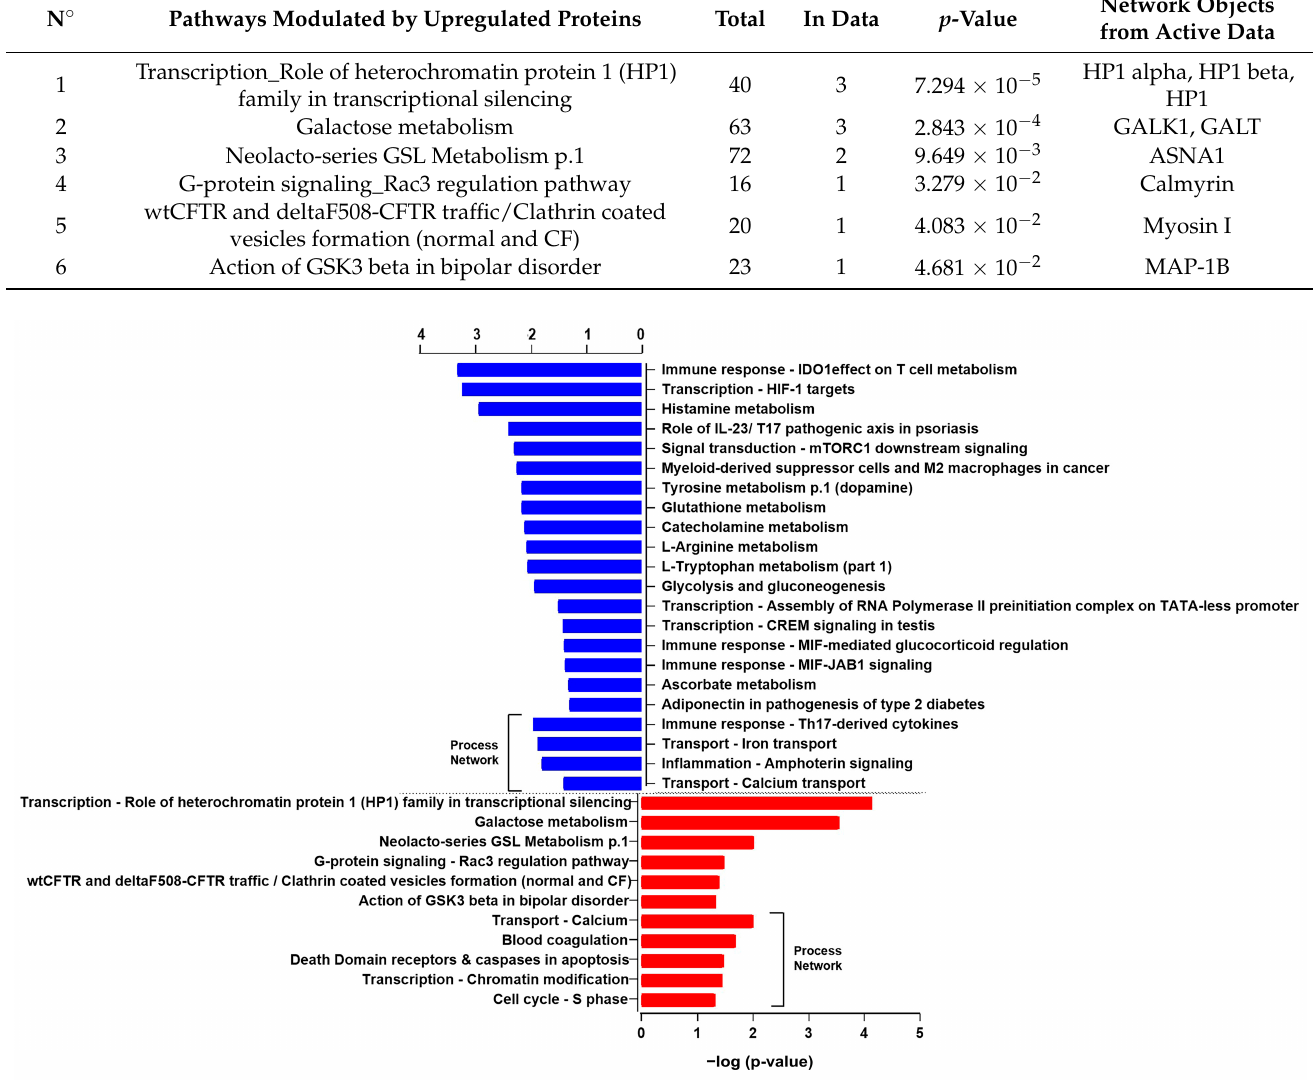
Figure 2. MetaCore enrichment analysis of proteomics data in LNCaP PCa cells overexpressing miR-423-5p. Significant pathways and process networks from downregulated (red) and upregulated (blue) proteins in LNCaP PCa cells expressing miR-423-5p mimic compared to control (empty vector). Quantitative SWATH-mass spectrometry data analysis performed with the SCIEX OneOmics cloud processing platform (n = 6 biological replicates).